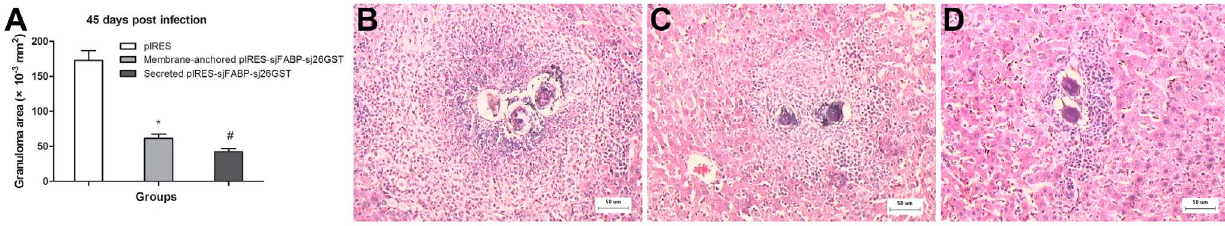
Figure 3. Reduction of hepatic granulomatous inflammation in the secreted vaccine group. (A) The granuloma area was calculated from isolated granulomas 45 days after infection (n=10 for each group).*P , 0.05, versus the control group; # P , 0.05, versus the membrane-anchored pIRES-sjFABP-sj26GST group. (B) Liver sections from the control (left panels), membrane-anchored (middle panels), and secreted groups (right panels) were examined by H&E staining.